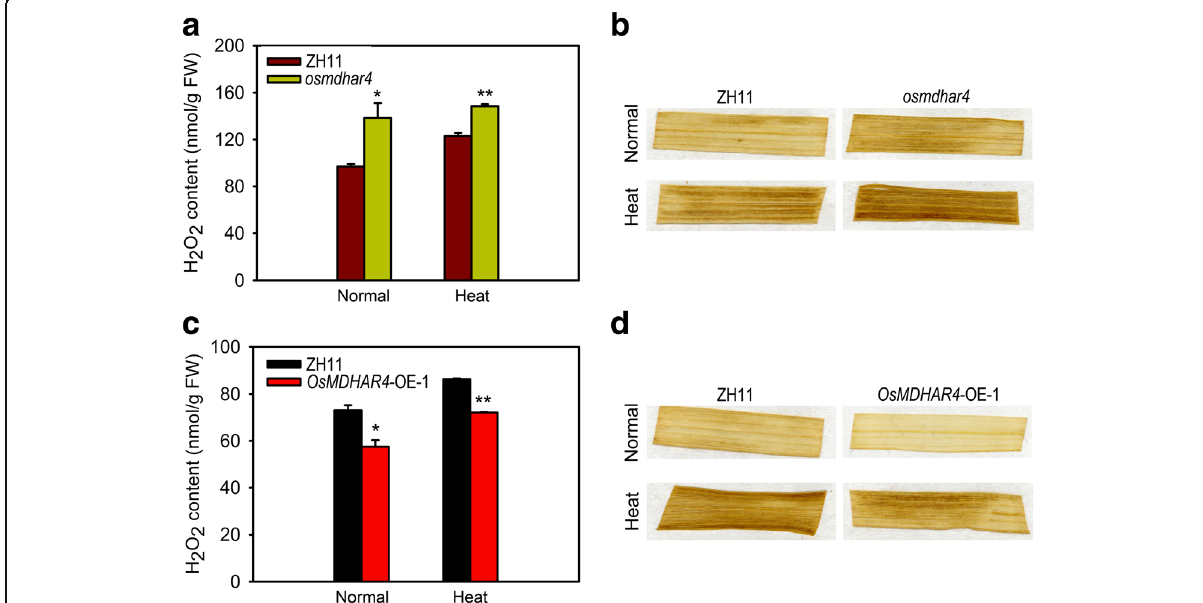
Fig. 6 Accumulation of H 2 O 2 in the osmdhar4 mutant and OsMDHAR4 -overexpressing plants. a Detection of the H 2 O 2 content of WT and the OsMDHAR4 mutant under normal and heat stress conditions. b DAB staining in the seedling leaves of WT and the osmdhar4 mutant under normal and heat stress conditions. c Detection of the H 2 O 2 content of WT and OsMDHAR4 -OE-1 plants under normal and heat stress conditions. d DAB staining in the seedling leaves of WT and OsMDHAR4 -OE-1 plants under normal and heat stress conditions. Error bars indicate the SE based on three biological replicates. *, P < 0.05, and **, P < 0.01, by Student ’ s t -test. FW, Fresh